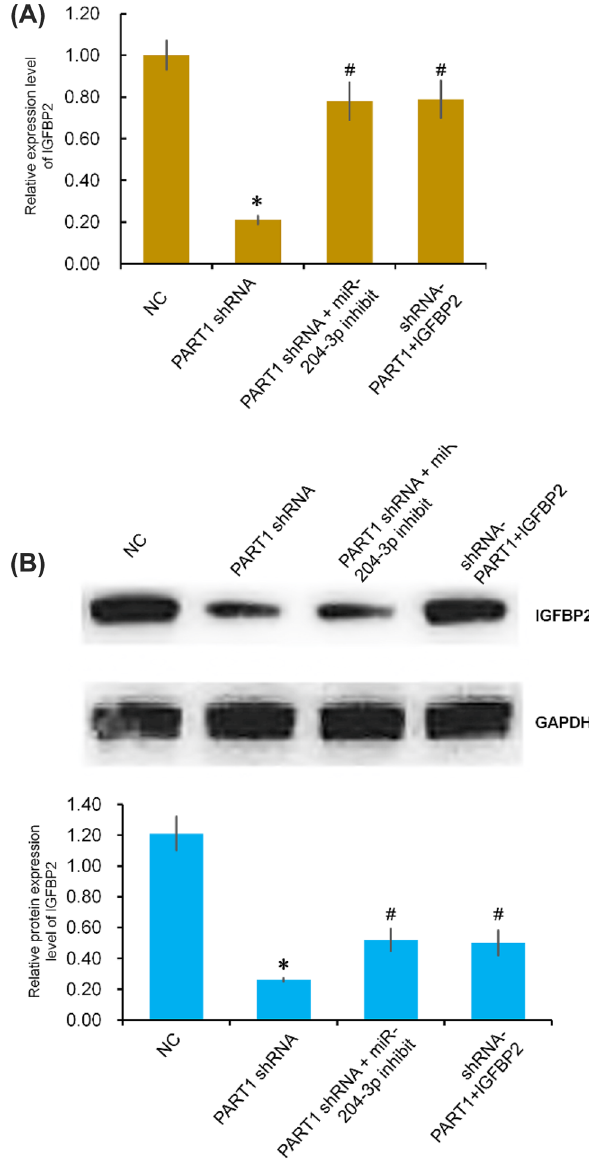
Figure 5: E ff ect of PART-1 and miR-204-3p on the expression of IGFBP-2 in the NC, PART1-shRNA, PART1-shRNA + miR204-3p inhibitor, and PART1-shRNA + IGFBP2 groups. (A) The relative expression level of IGFBP-2 mRNA was evaluated by quantitative RT ‒ PCR. (B) The protein expression level of IGFBP-2 was evaluated by western blot. GAPDH was used as an internal control; *p<0.05, PART1-shRNA group compared with NC group; # p<0.05 compared with PART1-shRNA